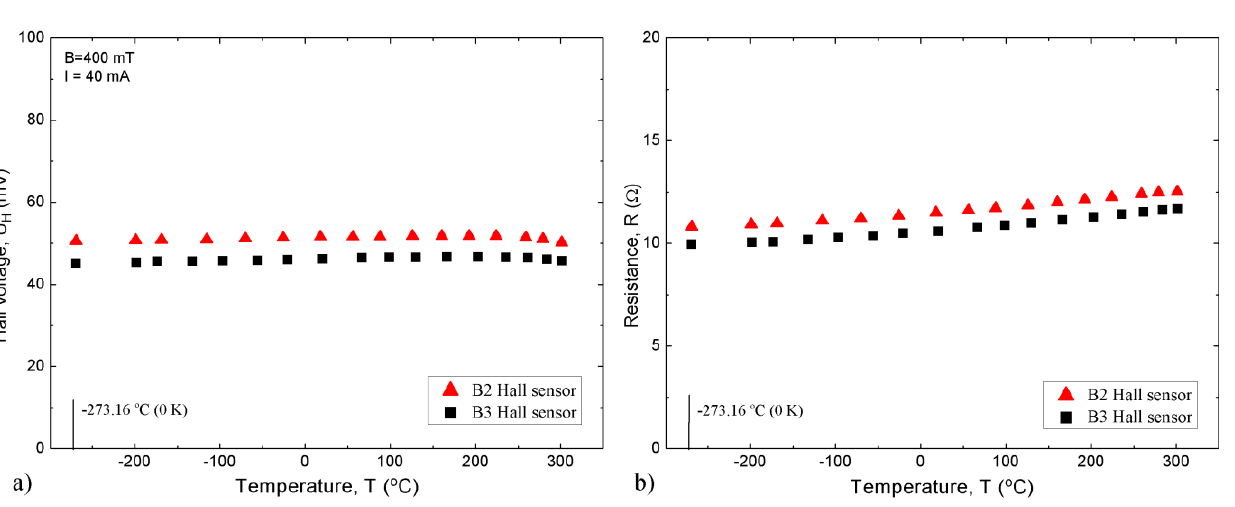
, and (b) resistance R sensors B2 H